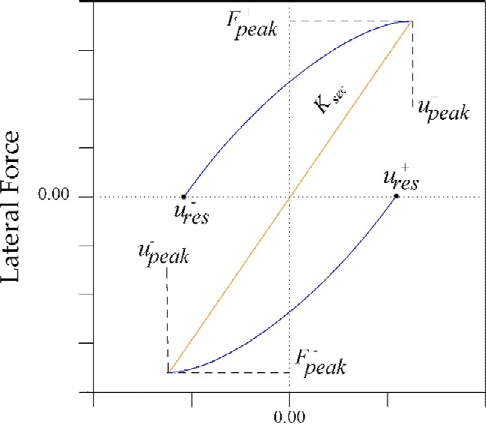
Figure 14. Peak and residual displacement in a single cycle.